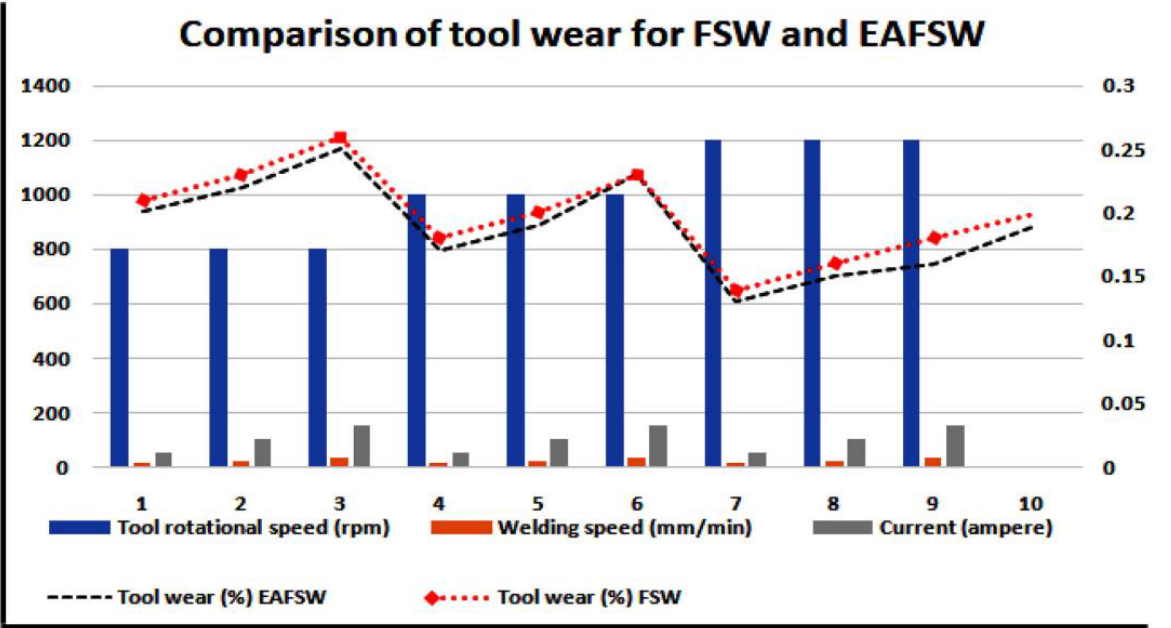
Figure 4. Comparison of wear of WC tool in FSW and EA-FSW samples. Reprinted with permission from ref. [39]. Copyright 2022 Elsevier.